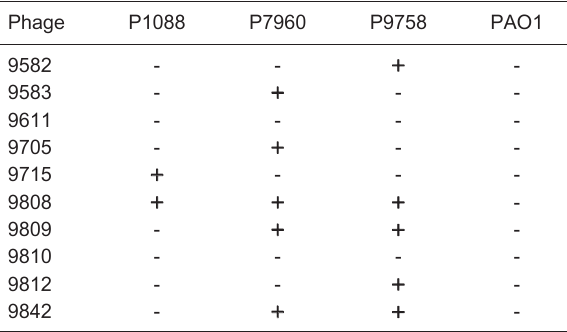
Table 3. Analysis of alternative host